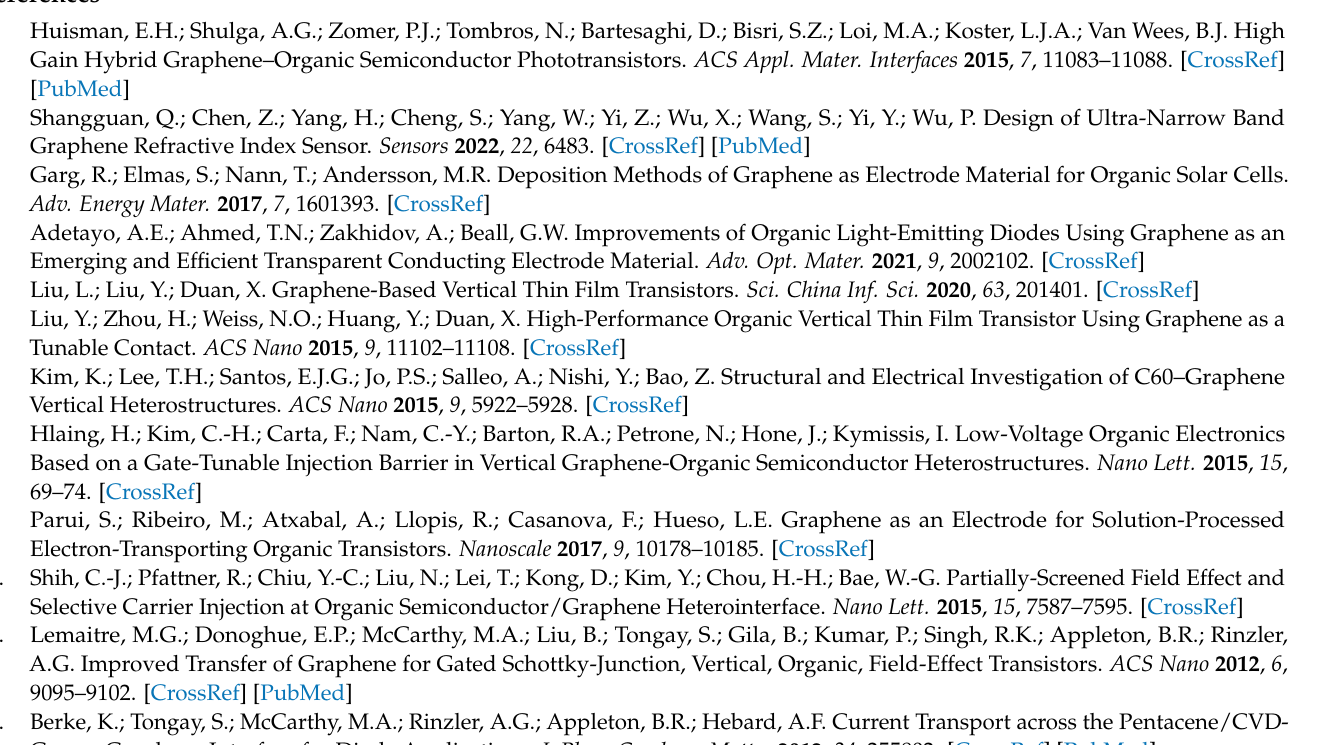
Figure S3: Raman spectroscopy of the Pentacene-GFETs. Figure S4: Output characteristics of the GFETS. Figure S5: Transfer characteristics of the GFETs. Figure S6: GFETs gate-leakage. Figure S7: Numerical derivative of the GFETs output characteristics. Figure S8: Transfer length method.